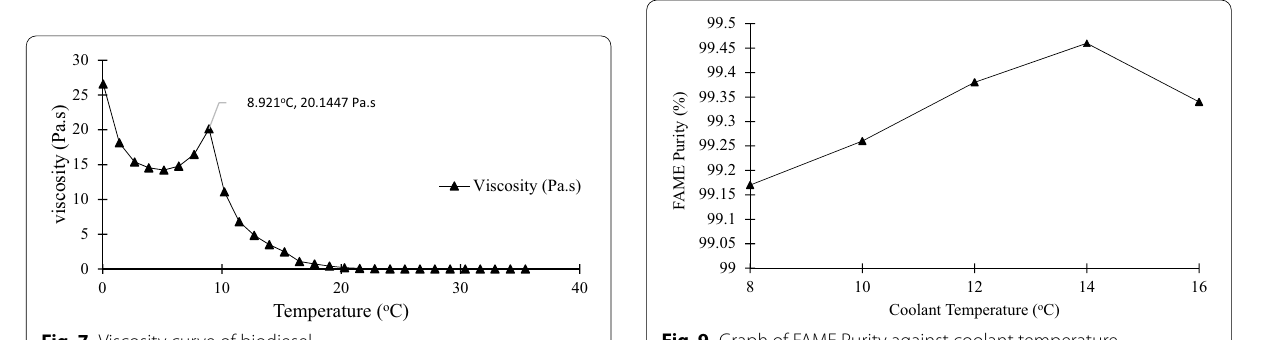
Fig. 7 Viscosity curve of biodiesel